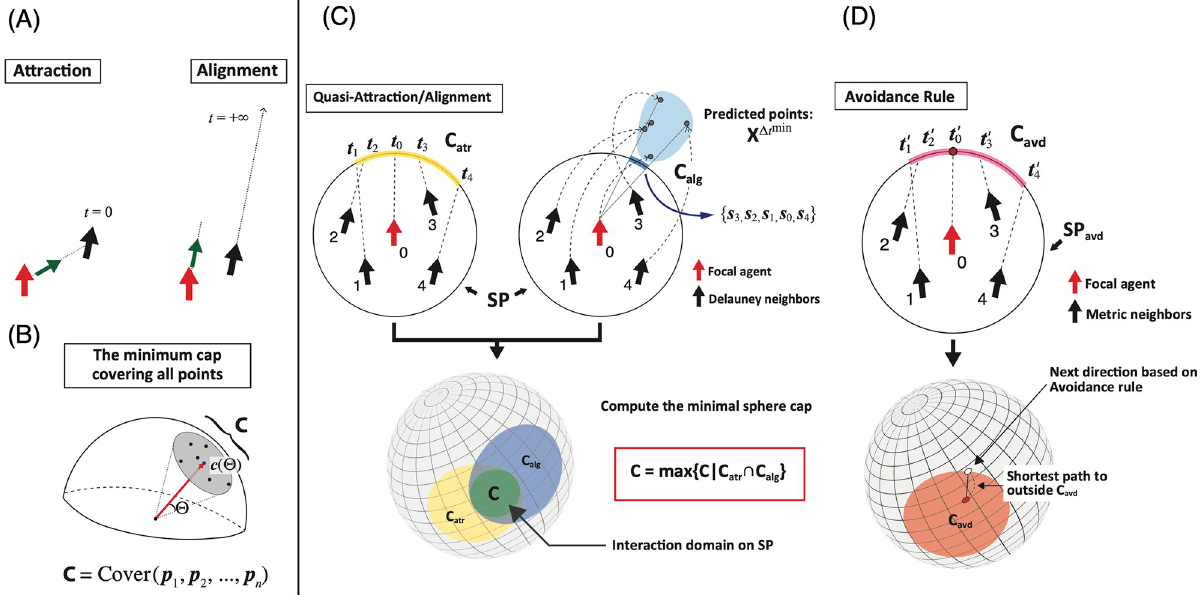
Fig 1. Brief sketch of the quasi-attraction/alignment algorithm. (A) Reinterpretations of attraction ( t = 0) and alignment ( t = 1 ). The red and black arrows indicate the focal agent and its neighbor, respectively, while the green arrow indicates the next direction. (B) A sketch of the cover function, which returns the minimum cap C on the interaction sphere SP , which covers all points p i (for the mathematical definition, see the Section 2 in S1 Appendix). (C) Left: The quasi-attraction projected on the plane. Each direction is extended to SP , where C (yellow) is the minimal sphere cap atr covering all points t . Right: The quasi-alignment projected on the plane, where C (blue) is the minimal sphere cap covering all points s . Lower: C j j T alg C (green) is the maximal sphere cap inside C . The focal agent selects its next direction randomly based on C . (D) A brief sketch of the avoidance atr alg algorithm. Upper: Each direction is extended to the repulsion area SP = { r || r | = R }, where C is the minimal sphere cap that covers all points on avd avd SP . (Lower) The focal agent determines its next direction uniquely as the shortest-distance position to the outside of C . avd avd